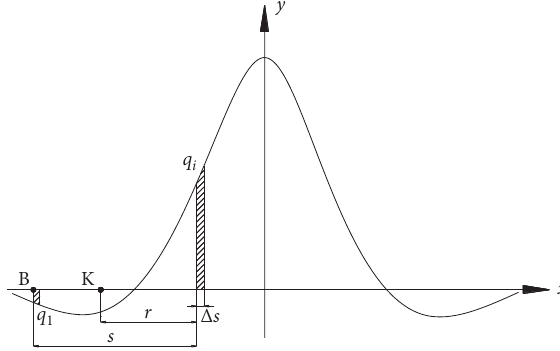
Figure 11: Schematic diagram of solving the vertical displacement